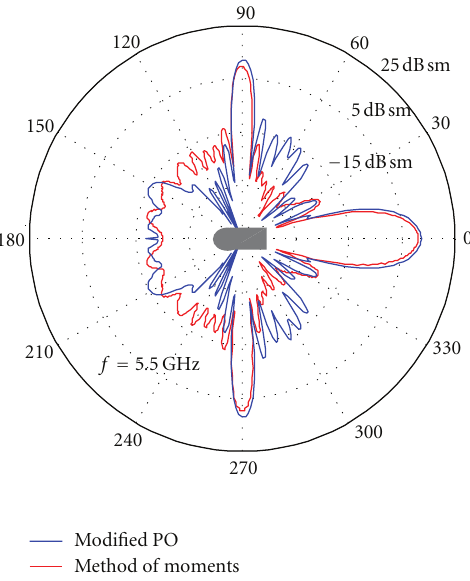
Figure 10: Monostatic RCS of the shell-shaped projectile at 5.5 GHz as a function of θ